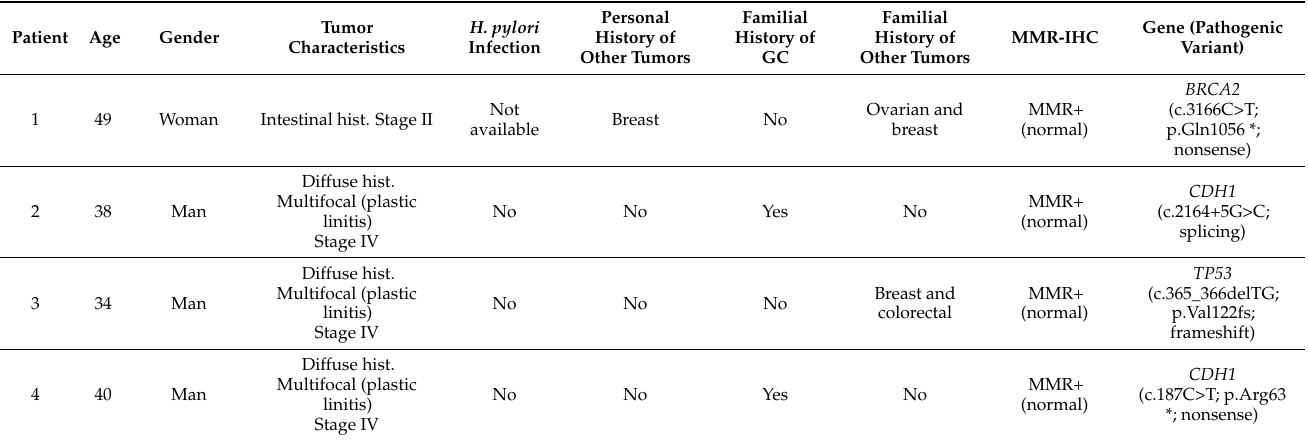
Table 3. Characteristics in patients with hereditary